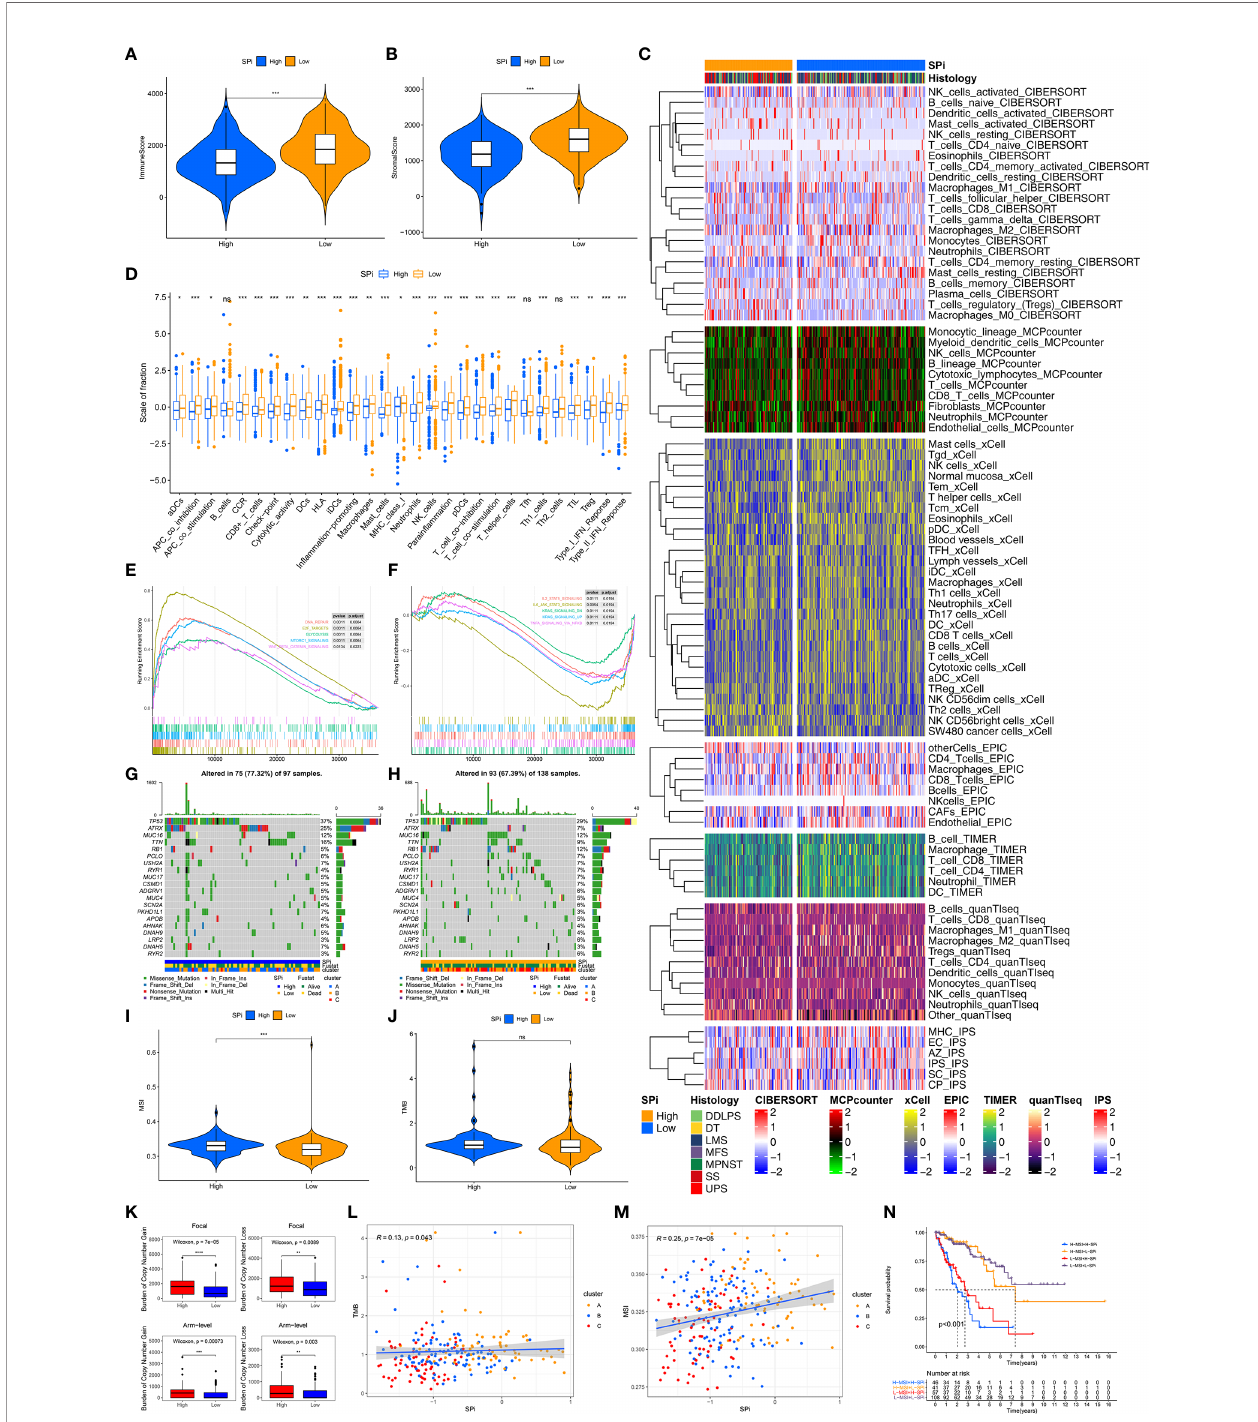
FIGURE 7 | Multi-omic characteristics of SPi. The differences of immune (A) and stromal (B) scores between patients with high and low SPi. (C) The landscape of immune in fi ltration in patients with high and low SPi. (D) The differences of enrichment scores of 29 immune gene sets re fl ective of innate and adaptive immunity in patients with high and low SPi. GSEA of patients with high SPi (E) and low SPi (F) . (G) Visualization of gene mutations in patients with high (G) and low SPi (H) . The differences of MSI (I) and TMB (J) between patients with high and low SPi. TMB value was subjected to the transformation of log2(X+1). (K) The differences of burden of copy number gain and loss between patients with high and low SPi. The correlation of TMB (L) and MSI (M) with SPi. (N) Survival analyses for patients with high MSI+ high SPi, high MSI +low SPi, low MSI + high SPi, and low MSI + low SPi. ***p < 0.001; **0.001 < p < 0.01; *0.01 < p < 0.05; ns (not signi fi cant), p >